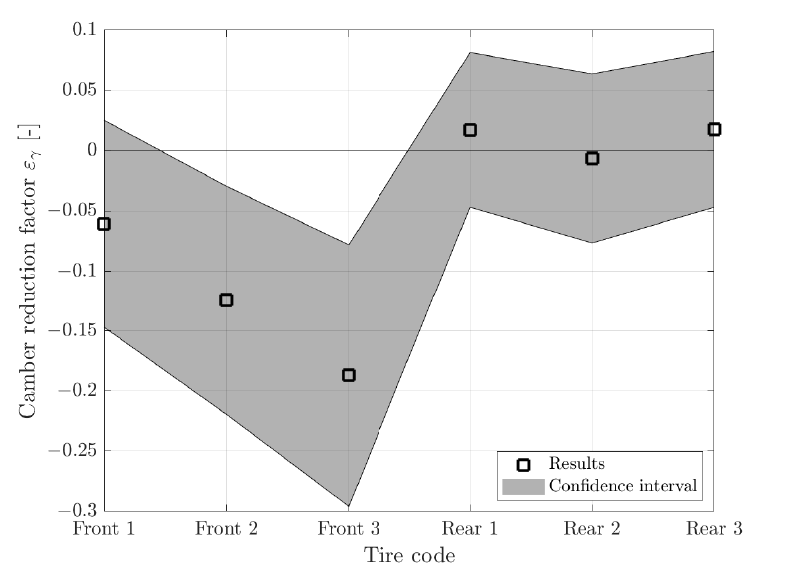
Figure 4. Camber reduction factor for the tested